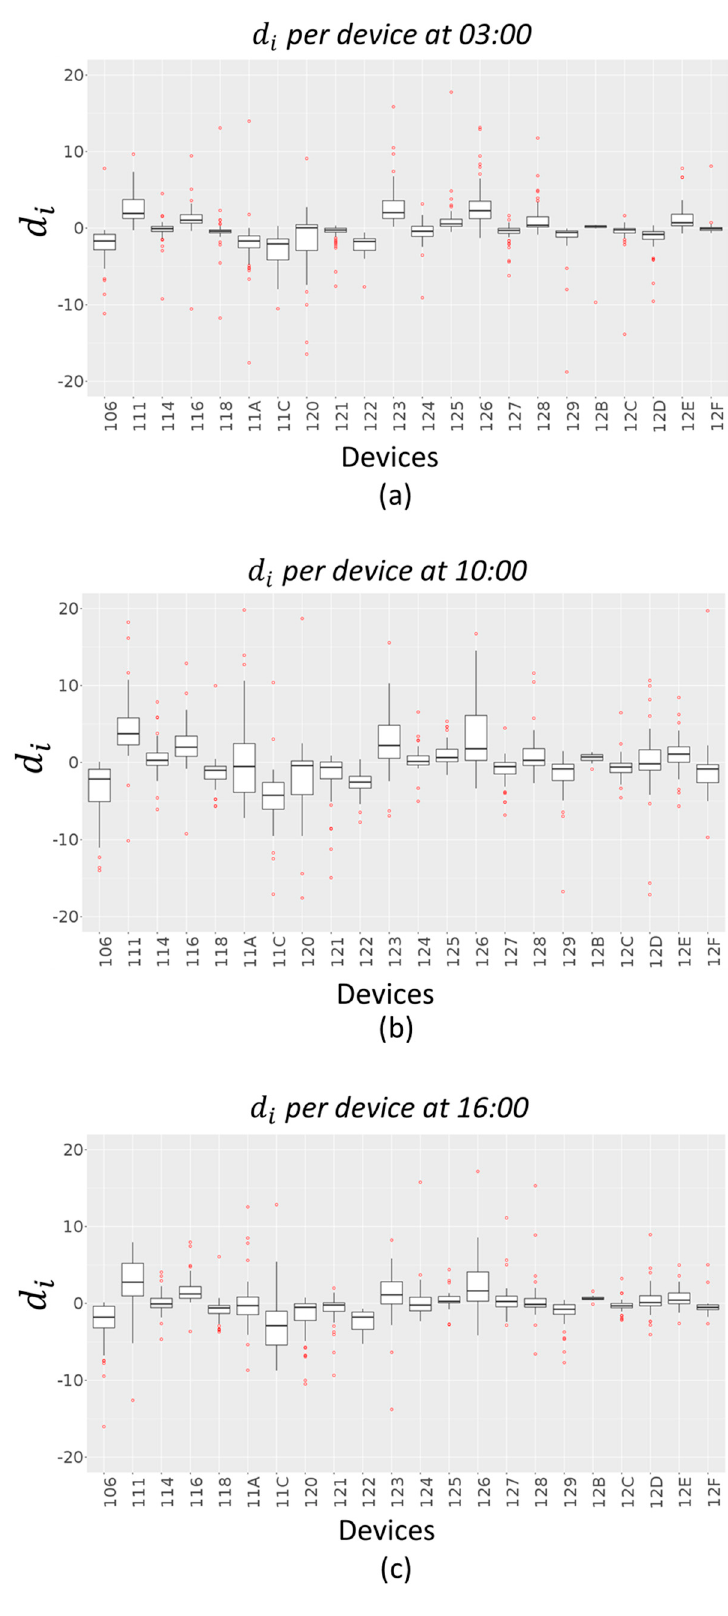
Figure 10. PM 10 working days error box plots per device (Akima Method) at 03:00 ( a ), 10:00 ( b ) and 16:00 ( c ).